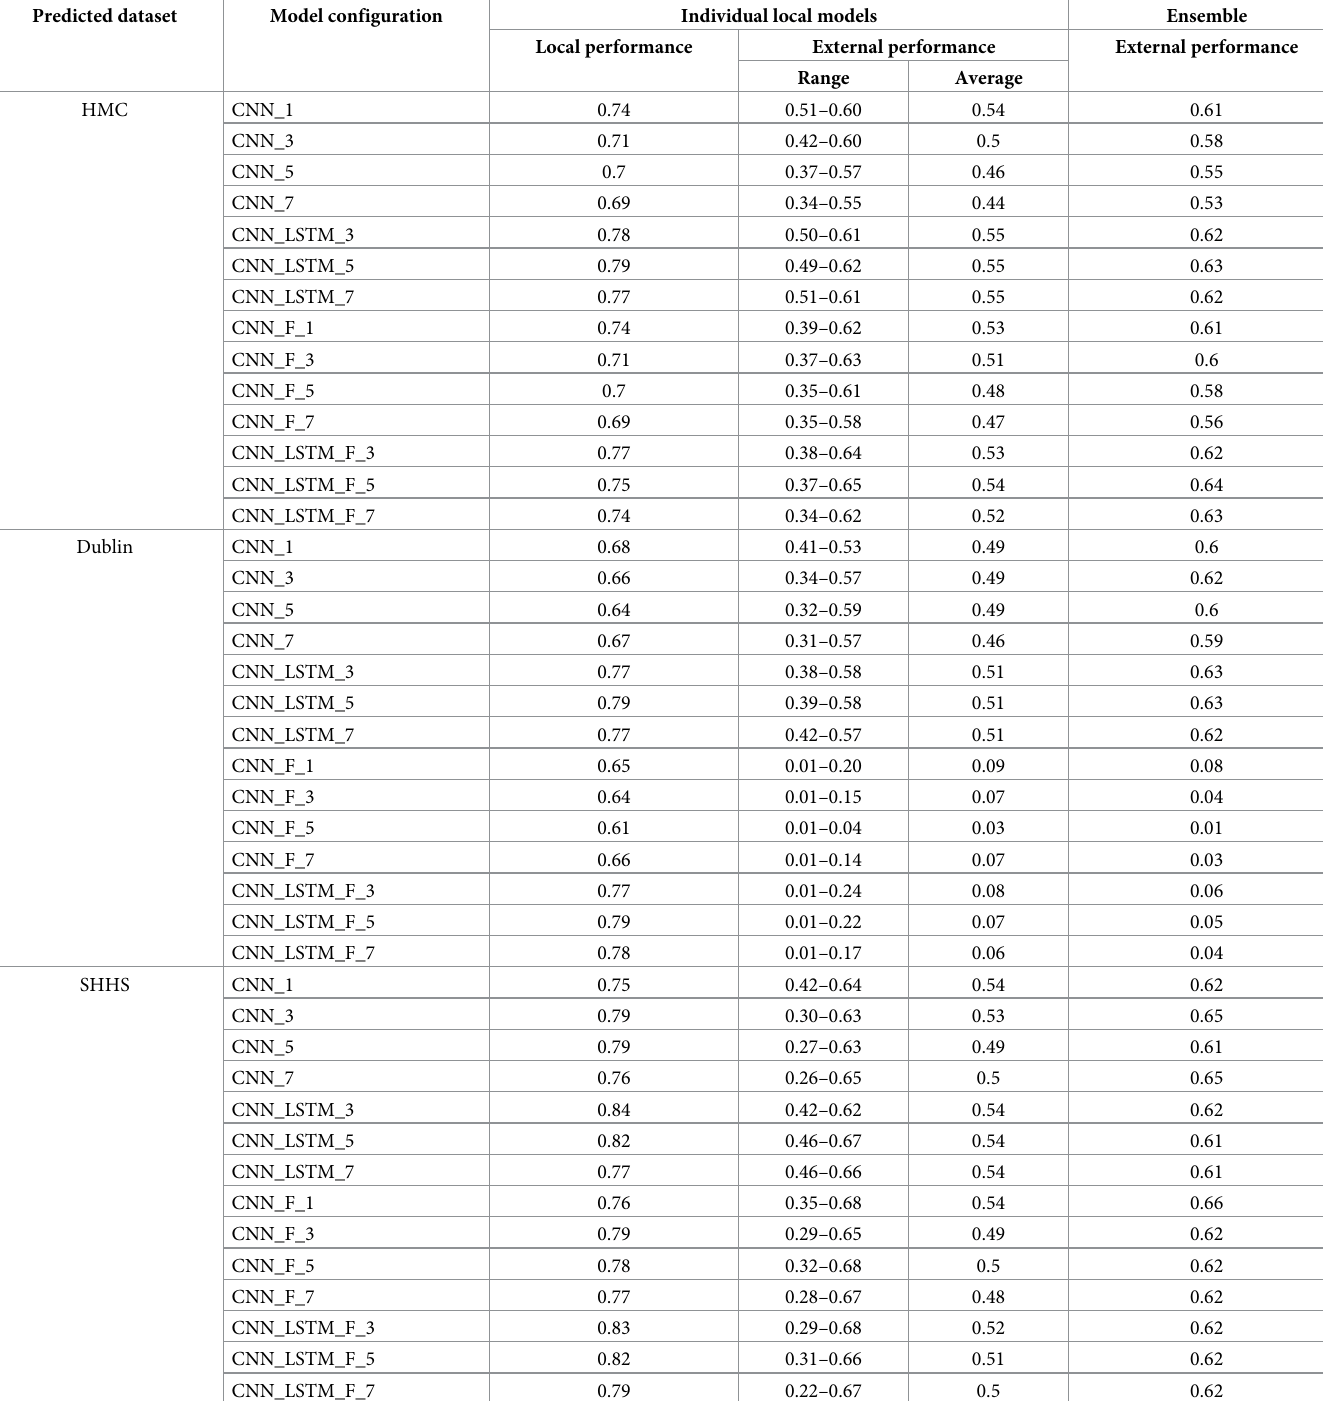
Table 3. Performance comparison between individual models and the ensemble approach in the local and external validation scenarios. Predicted